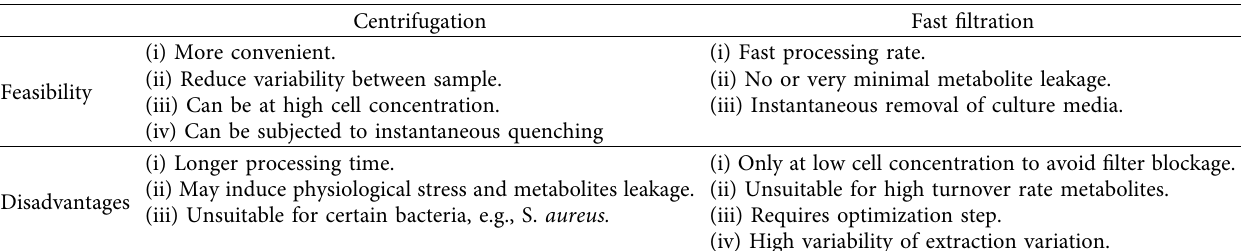
Figure 2: General metabolite sample preparation methods workflow for laboratory scale bacterial metabolomics study. (a) Quenching. (b) Harvesting/separation of cells by centrifugation. (c) Extraction of intra- and extracellular metabolites. Table 3: Summary on comparison between centrifugation and fast filtration method for cell